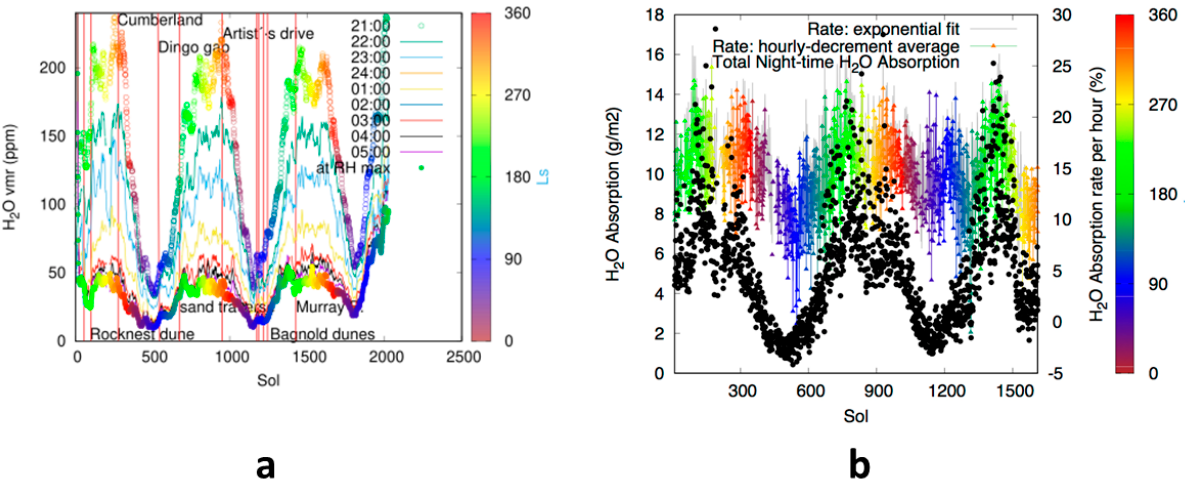
Figure 1. Night-time water behavior inferred at Gale crater from REMS data. ( a ) Night-time water VMR (units of ppm) for the first 2027 sols of Curiosity operations. The different colored lines show the maximum value within each hour interval as measured from 21:00 (to 22:00) to 4:00 (to 5:00) local time. The time of the year (Ls) for a given measurement is shown using the color scale on the right. ( b ) Night-time water absorption rates for the first 2027 sols of Curiosity operations. The rate calculated with the exponential law is coincident with the hourly variation. The measured night-time decrement of VMR between 21:00 and 05:00 LMST is converted into g/m 2 for each sol of the mission (here at 230 K mean temperature and scaled for 6.1 mbar).